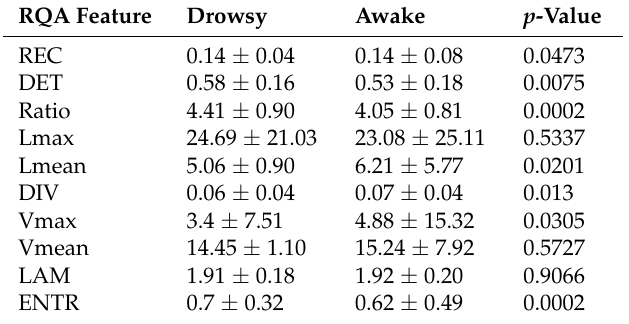
Table 1. Statistical significance of recurrence quantification analysis (RQA) features for awake/drowsy differentiation from electrocardiogram (ECG) signals. Recurrence (REC), determinism (DET), ratio, longest diagonal size (Lmax), average diagonal length (Lmean), divergence (DIV), maximum vertical line length (Vmax), average vertical line length (Vmean), laminarity (LAM), and entropy (ENTR) features were measured.